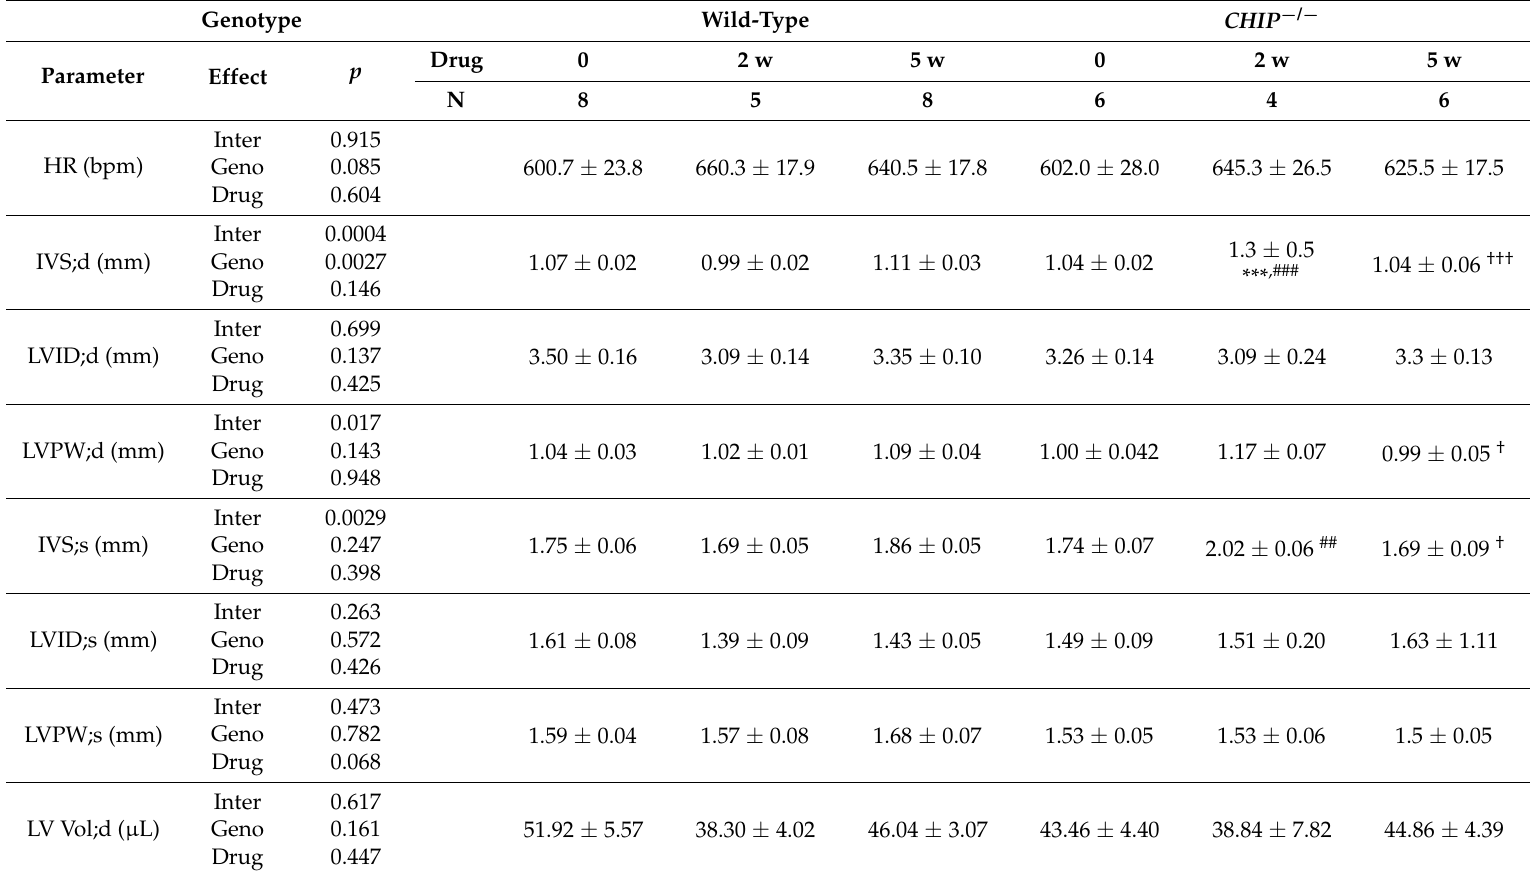
Table 3. Echocardiogram results of study mice. Left ventricular dimension data obtained via conscious echocardiography. When applicable, measurements reported at diastole or systole (d or s respectively), g, grams, bpm, beats per minute, mm, millimeters, IVS, interventricular septum. LVID, left ventricular internal diameter, LVPW, left ventricular posterior wall, LV Vol, left ventricle volume; EF, ejection fraction. Results of two-way ANOVA on the main effects (Geno = genotype, Drug = w of treatment) and the interaction (Inter) are indicated, Tukey’s post-test: *** p < 0.001 comparing 2 w vs. 0 w, # , ## , and ### indicate p < 0.05, 0.01, and 0.001